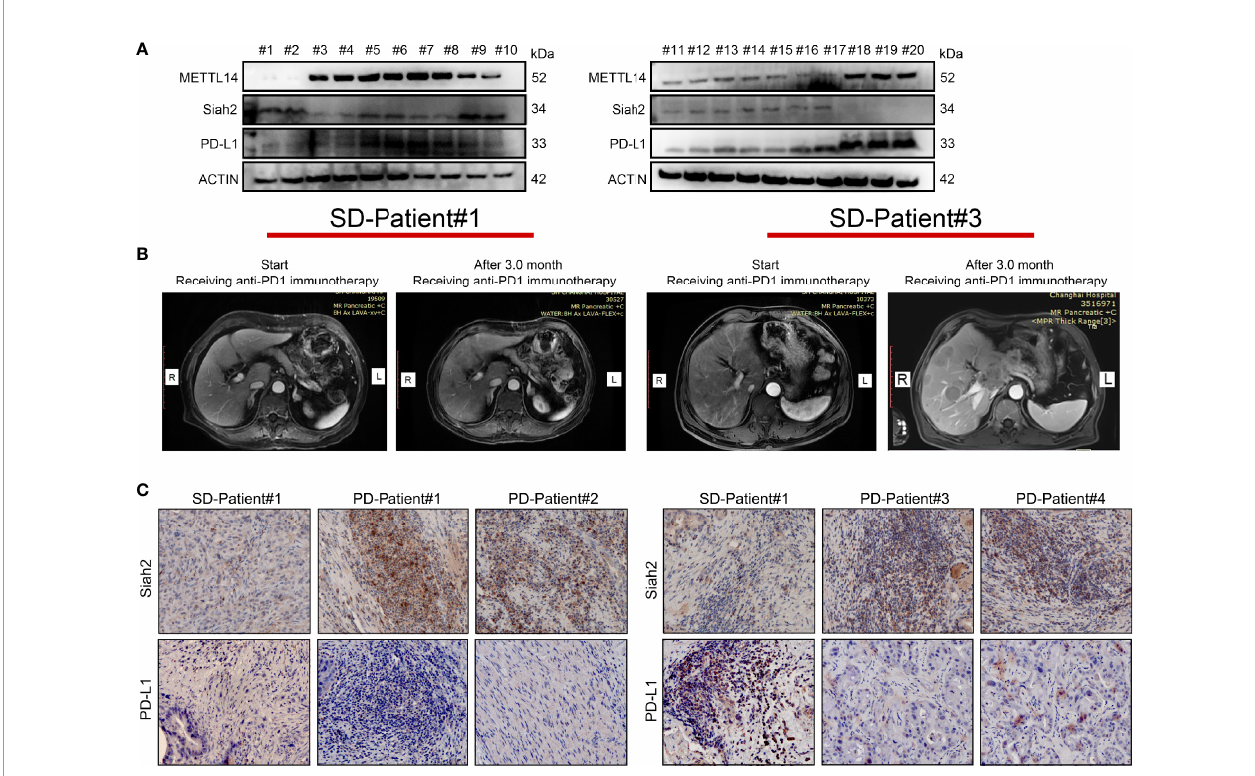
FIGURE 8 | Correlation between METTL14, Siah2, and PD-L1 in clinical CCA specimens. (A, B) , Western blot analysis detected METTL14, Siah2, and PD-L1 protein levels in clinical CCA tumor samples. (B) , CT imaging of SD#1-CCA Patient and PD#3-CCA Patient. (C) , Siah2 and PD-L1 expression in the tumor area of CCA tissues detected by IHC. Magni fi cation X 200. PD, progressive disease; SD, stable